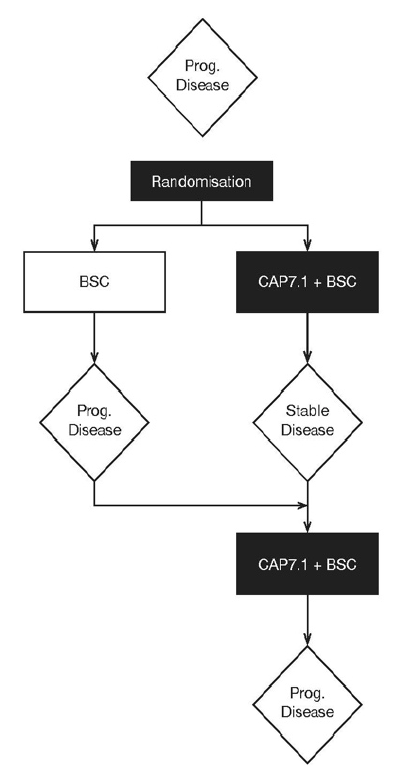
Figure 1. Study design for this Phase II randomised controlled trial of CAP7.1 compared with best supportive care in patients with advanced biliary tract cancer.